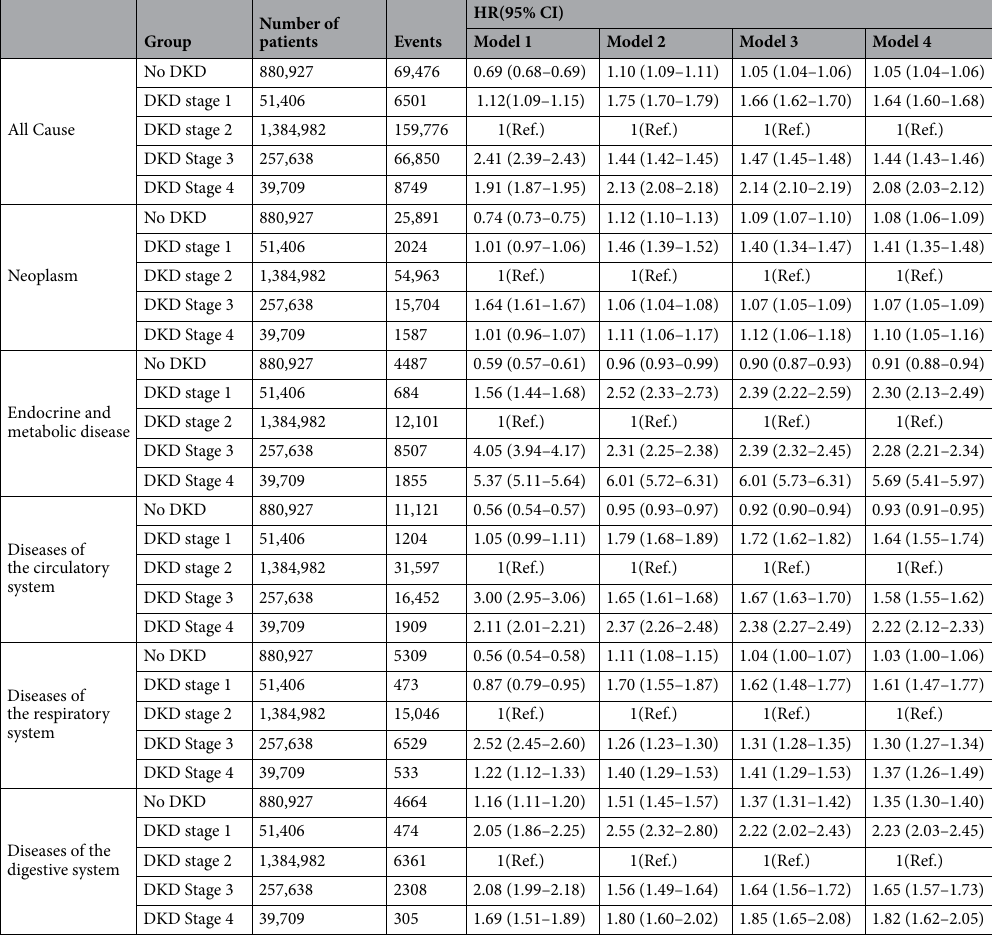
Table 3. Risk of causes of death according to DKD stage. DKD diabetic kidney disease; HR hazard ratio; 95% CI 95% confidence interval. Model 1 was non-adjusted. Model 2 was adjusted for age and sex. Model 3 was adjusted for variables in model 2 and BMI, smoking history, alcohol consumption and physical activity Model 4 was adjusted for variables in model 3 and comorbidities (hypertension, dyslipidemia, COPD, cancer, and